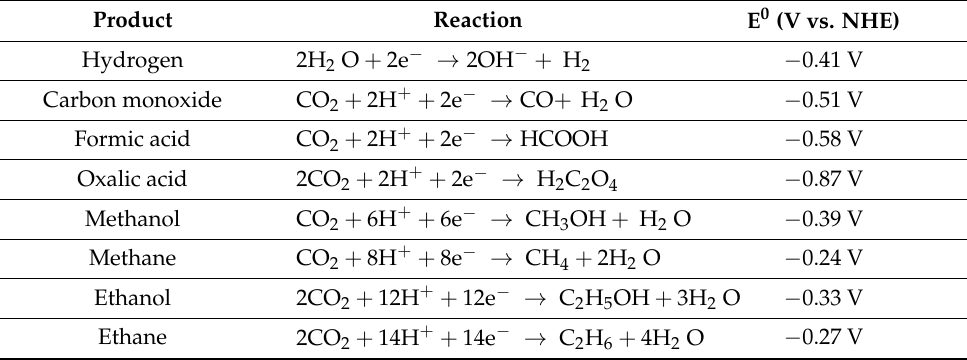
Table 2. Possible products of CO 2 and water reduction with corresponding reduction potential (versus NHE at pH 7 in aqueous solution). Adapted from [106–108] Copyright 2019, Elsevier; 2020 The Royal Society of Chemistry; 2019, American Chemical